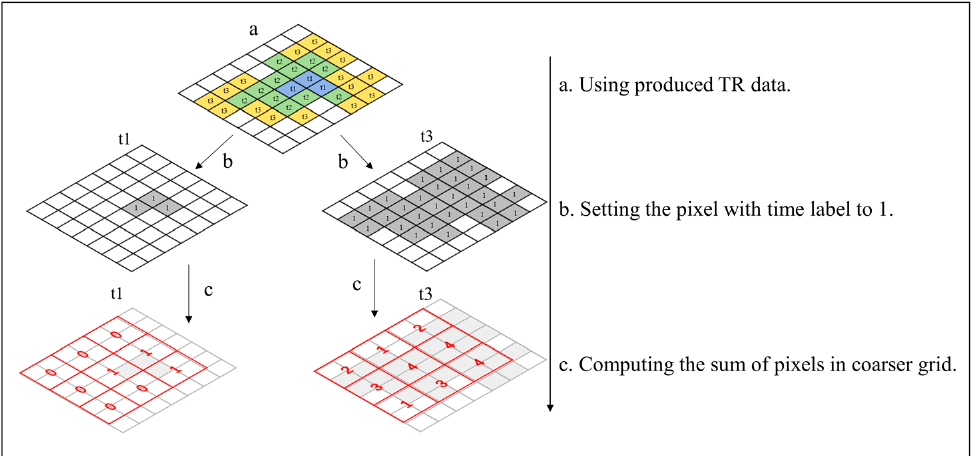
Figure 3. The data preparation for computing speed and acceleration. The data take the TR data with expansive features as an example. One grid can contain four pixels in this